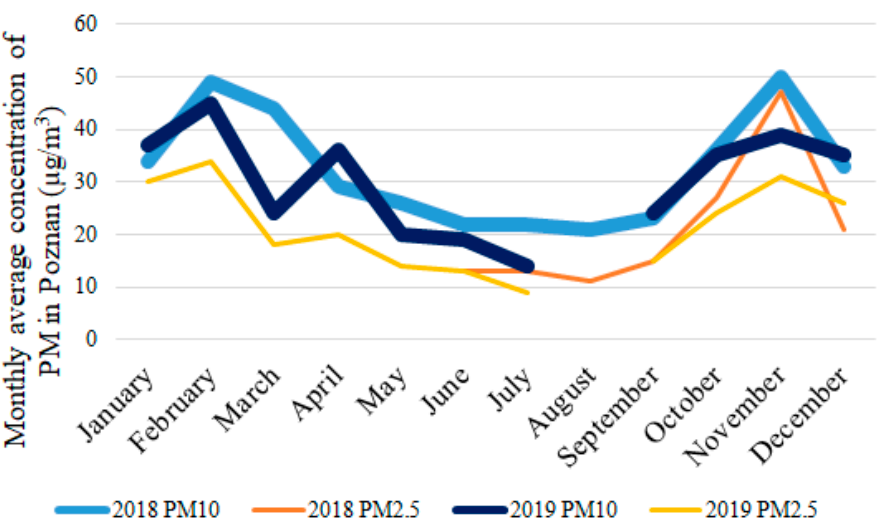
Figure 9. Monthly average concentration of PM10 and PM2.5 in Poznan in 2018 and 2019, own study based on [16].